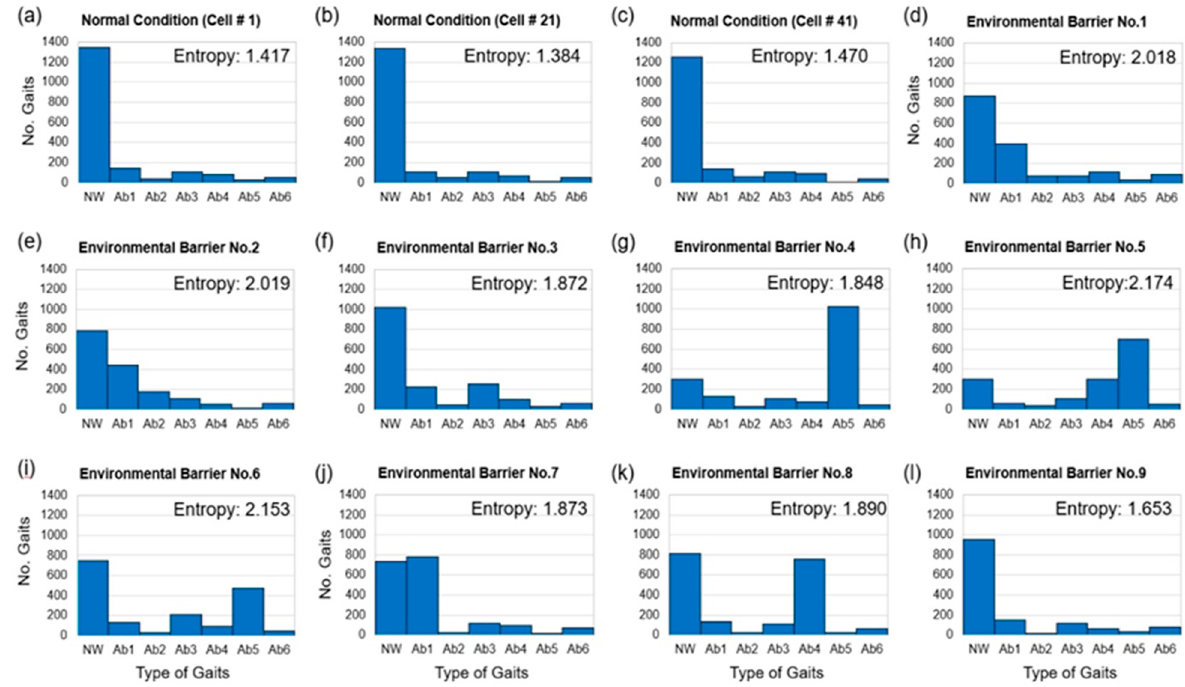
Figure 5. Behavioral response distribution: ( a – c ) Behavioral response distribution during normal conditions (Cell Number 1, 21, and 41, respectively) and ( d – l ) behavioral response distribution (Cell Number 5, 9, 24, 28, 30, 35, 39, 47, and 60, respectively).